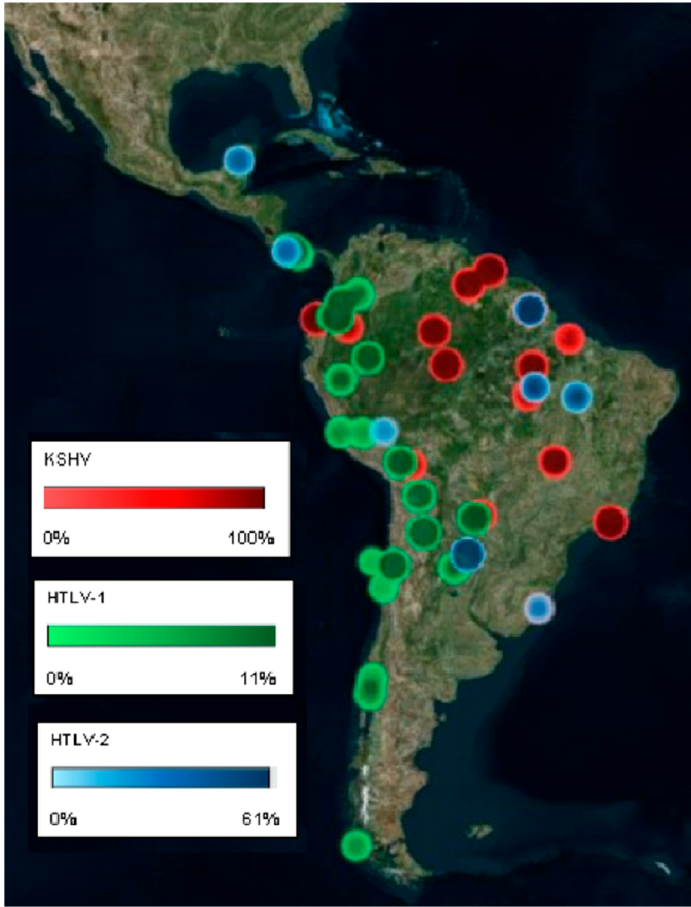
Figure 4. KSHV and human T-lymphotropic virus (HTLV) locoregional prevalence among Amerindian tribes.